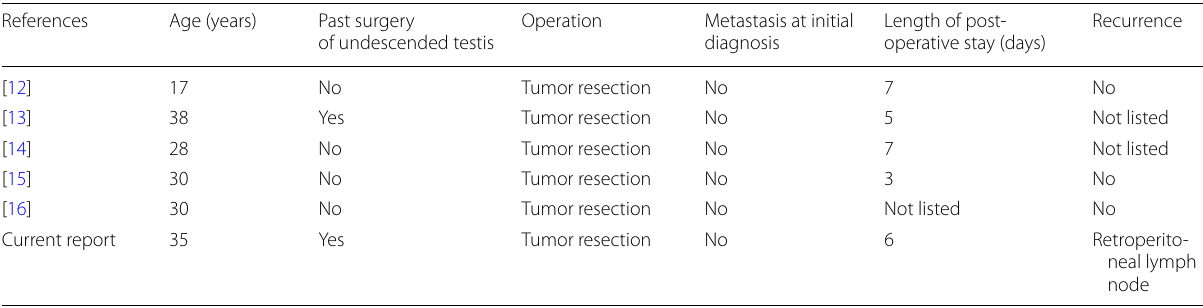
Table 1 The literature review of cases of intraperitoneal hemorrhage from rupture of intra-abdominal testicular